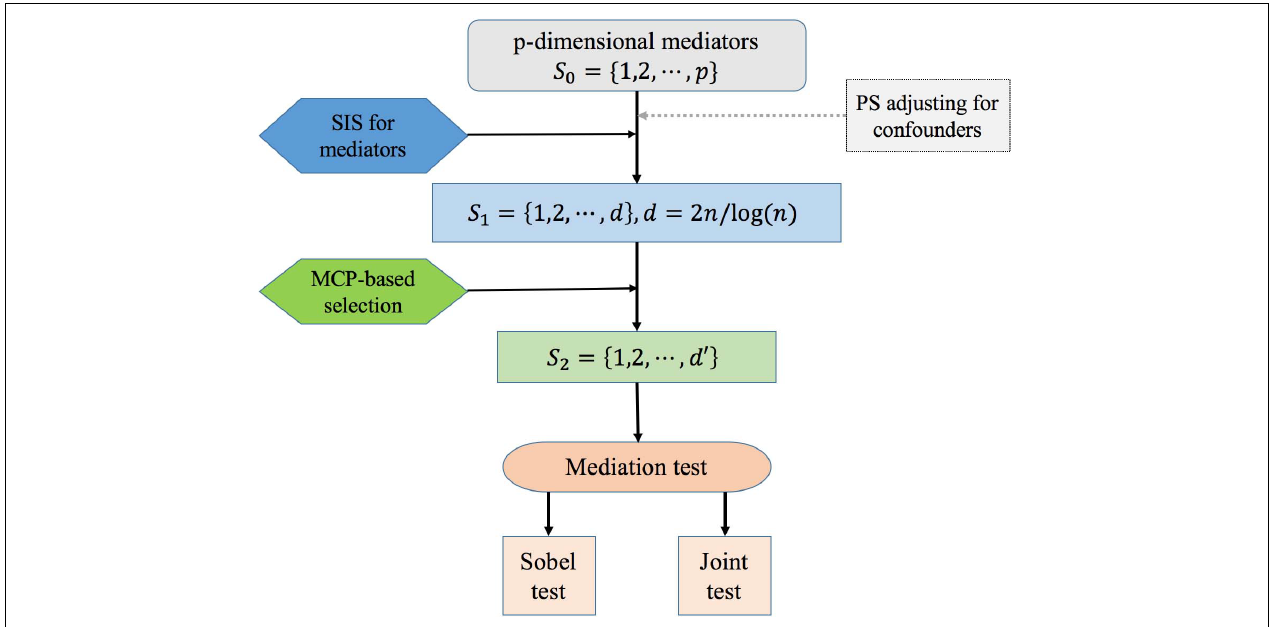
FIGURE 2 | Overall workflow for high-dimensional mediation analysis. The workflow includes the main processes: (0) adjusting for confounders based on the propensity score method; (1) using SIS technique for preliminary screening; (2) conducting MCP-based variable selection; (3) testing for mediation effects. (0–3) is correspond to Step0–Step3 in the